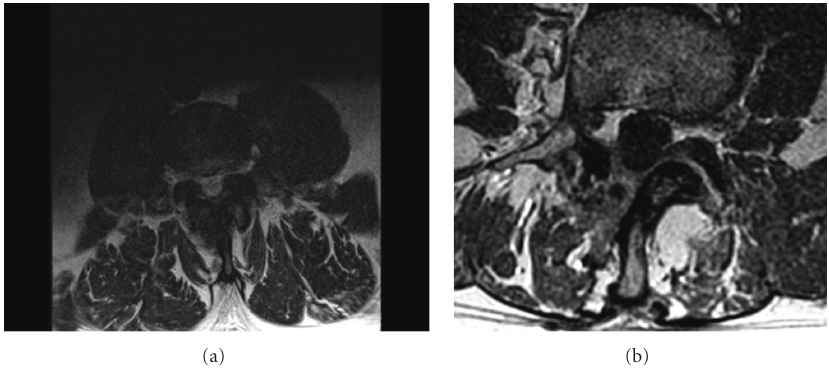
Figure 3: Preoperative (a) and postoperative (b) cross-sectional MRI of lumbar spine demonstrating significant enlargement of thecal sac.